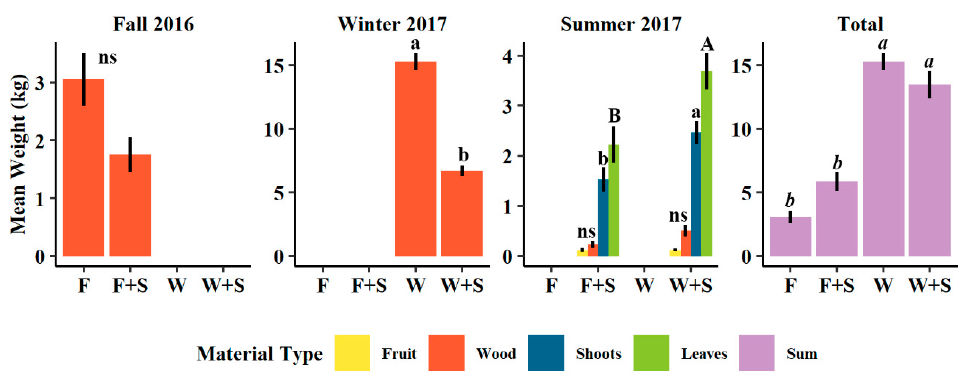
Figure 2. Mean weight of pruned wood (orange), fruit (yellow), one-year-old shoots (blue), leaves (green), and sum of all cut materials (purple) in Fall 2016, Winter 2017, Summer 2017, and total among these three pruning dates of trees subjected to fall (F), fall and summer (F + S), winter (W), or winter and summer (W + S) pruning treatments. Error bars ± standard error. Di ff erent letters indicate significance di ff erence among means within pruning date and cut material type (capital letters for leaves, lowercase letters for shoots in Summer 2017, italic letters for total of all cut material types, p < 0.05, Tukey HSD). “ns” indicates no significant di ff erence among means ( p > 0.0, Tukey